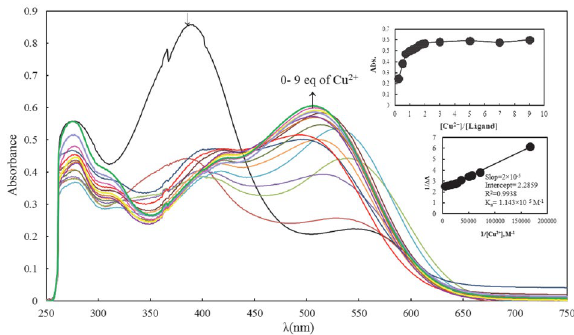
Fig. 7. Changes in the UV–vis spectra of 2 (0.020 mM) upon titra- tion by Cu(CH 3 COO) 2 in a DMSO solution, where the concentra- tion of Cu(CH 3 COO) 2 varies from 0.004–0.18 mM. Insets: above: absorption at selected wavelength versus equivalents of cation add- ed, down; Benesi–Hildebrand plot of the receptor with Cu 2+ ion.